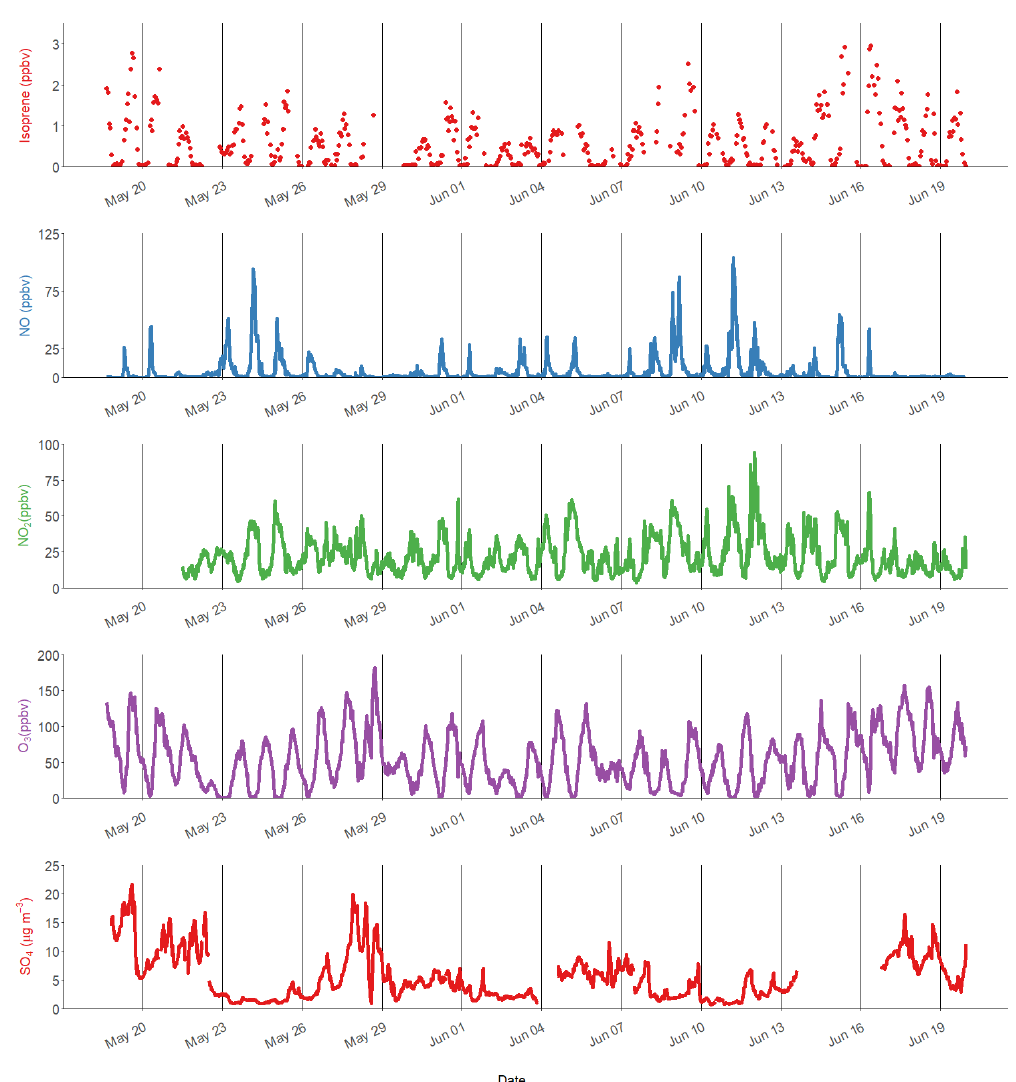
Figure 1. Time series of isoprene, nitric oxide (NO), nitrogen dioxide (NO 2 ), ozone (O 3 ) and particulate sulfate (SO 4 ). The black lines represent midnight every